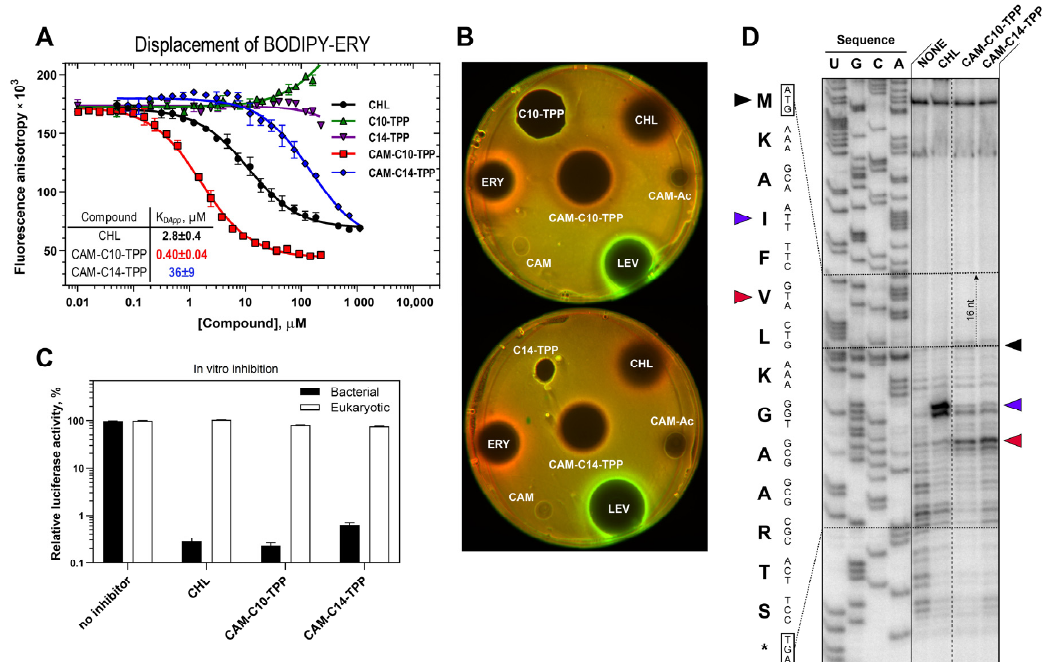
Figure 2. Binding affinity to bacterial ribosomes and the inhibition of protein synthesis by CAM-C10-TPP and CAM- C14-TPP. ( A ) A competition-binding assay to test the displacement of fluorescently labeled analogs of the erythromycin, BODIPY-ERY, from E. coli 70S ribosomes in the presence of increasing concentrations of CHL (black circles), CAM-C10- TPP (red squares), CAM-C14-TPP (blue rhombus), decyl(triphenyl)phosphonium bromide (C10-TPP, green triangles), or tetradecyl(triphenyl)phosphonium bromide (C14-TPP, purple triangles), measured by fluorescence anisotropy. All reactions were repeated four times. Error bars represent the standard deviation. The resulting values for the apparent dissociation constants (K Dapp ) are shown on the plot. ( B ) Testing of the CAM-C10-TPP and CAM-C14-TPP activity using E. coli BW25113 ∆ tolC pDualrep2 reporter strain. The induction of the red fluorescent protein expression (green halo around the inhibition zone, pseudocolor) is triggered by DNA-damage, while the induction of Katushka2S protein (red halo) occurs in response to ribosome stalling. Levofloxacin (LEV), erythromycin (ERY), chloramphenicol (CHL), N-acetyl-chloramphenicol amine (CAM-Ac), C10-TPP, and C14-TPP are used as the controls. ( C ) The inhibition of protein synthesis by 30 µ M of CHL, CAM-C10-TPP, or CAM-C14-TPP in vitro in the cell-free bacterial (black columns) and eukaryotic (transparent columns) transcription–translation coupled system. The relative enzymatic activity of in vitro synthesized firefly luciferase is shown. The error-bars represent the standard deviations of the mean of three independent measurements. ( D ) Ribosome stalling by CAM-Cn-TPP on trpL mRNA in comparison with CHL, as detected by a reverse-transcription primer-extension inhibition (toeprinting) assay in a cell-free translation system. The nucleotide sequences of trpL mRNA and their corresponding amino acid sequences are shown on the left. The black arrowhead marks the translation arrest at the start codon, while the colored arrowheads point to drug-induced arrest sites within the coding sequences of the mRNAs used. Note that due to the large size of the ribosome, the reverse transcriptase used in the toeprinting assay stops 16 nucleotides downstream of the codon located in the